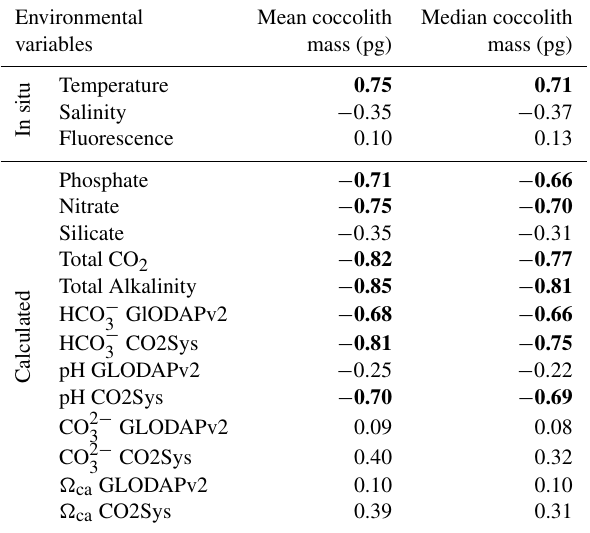
Table 4. Correlation matrix between mean and median coccolith values and the environmental variables. Significant Pearson corre- lation coefficients are indicated in bold ( p < 0 . 05). Measurements in situ and calculated values are indicated.